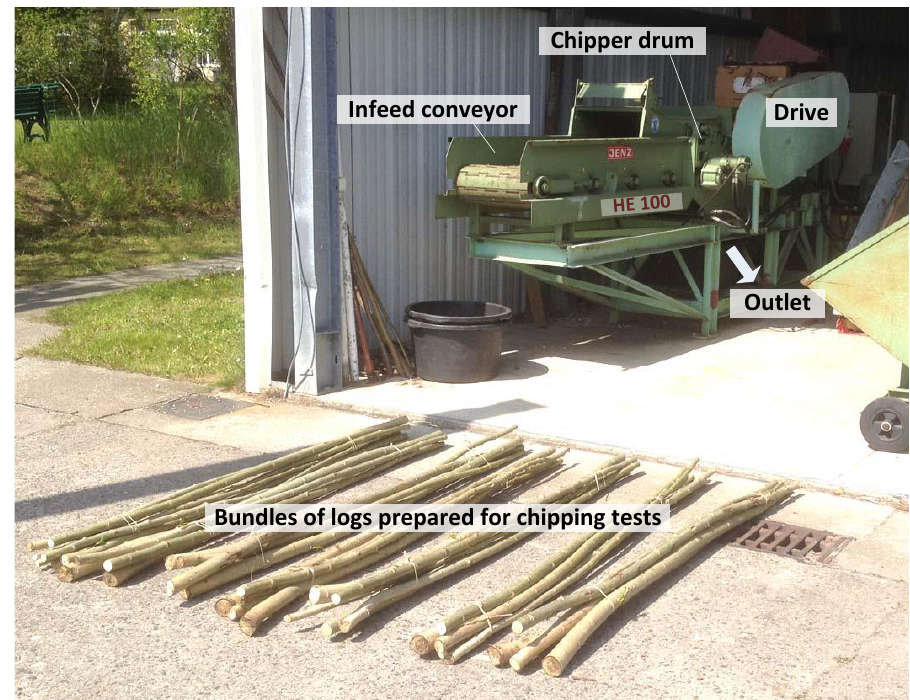
Figure 3. Bundling of the chipping samples and setup of the experimental stand (chipper HE 100 500, JENZ, Petershagen, Germany).